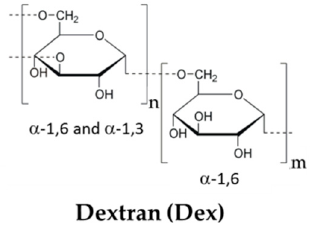
Figure 17. The structure of dextran.